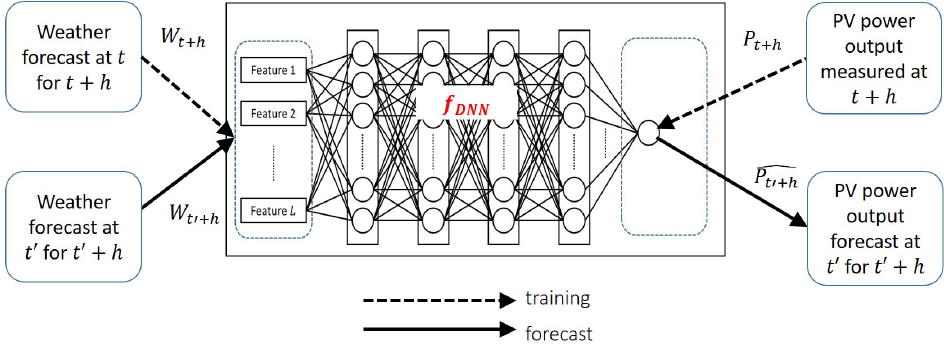
Figure 8. Deep Neural Network (DNN)-based model to forecast PV power output